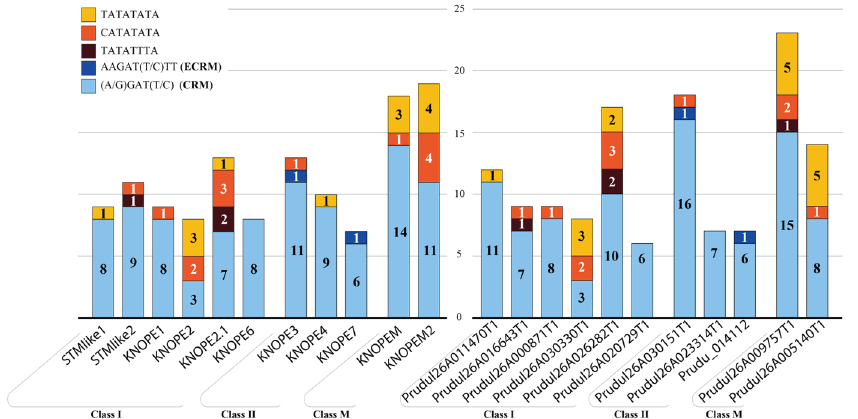
Figure 4. Cytokinin binding motifs residing on PRUNOX genes’ promoters of P. persica and P. dulcis (left and right panels). The score accounts (covering 1.5 kb region before the start codon in Table S4) refer to the experimentally determined extended (ECRM; blue) and core (CRM; light blue) motifs [38], as well as octameric sequences (yellow/orange/brown) enriched in CK-responsive promoters [39].